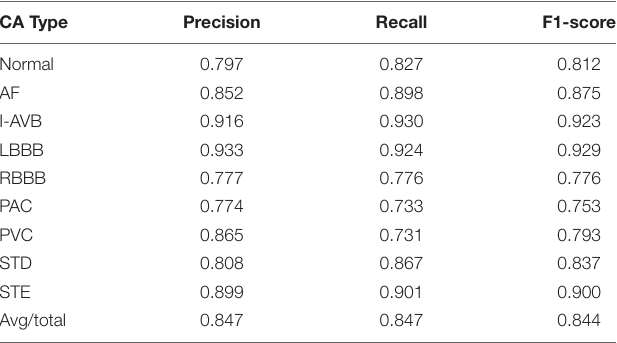
TABLE 2 | Classification performance of Inception-ResNet-v2 based on RP